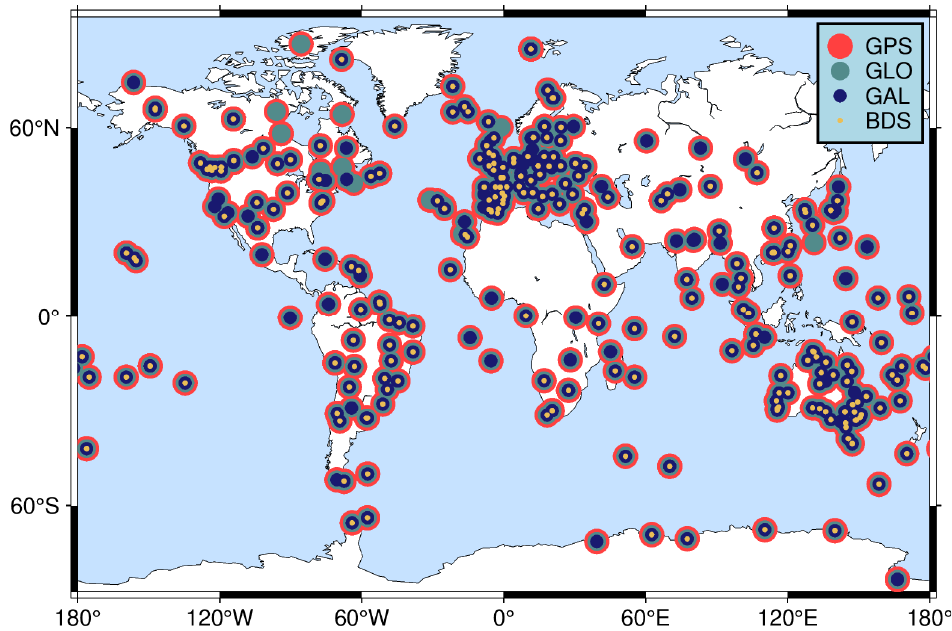
Figure 1. GPS, GLONASS, GALILEO and BDS stations distribution.